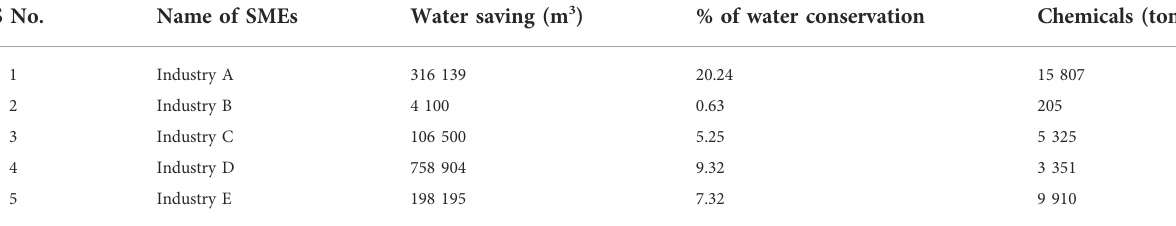
TABLE 5 Volume fraction of water and chemical conservation (%) by industries. S No.